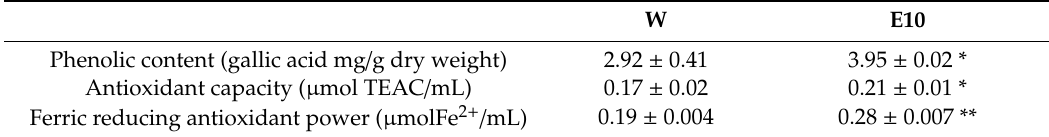
Table 2. Phenolic content and antioxidant capacity of potato water extract and potato ethanol extract. Data are reported as mean ± SE (n.3). For each row, asterisks indicate significant di ff erences between solvents (W = water, E = 10% ethanol) used for the extraction of potato peels (P) according to Student t test at p < 0.05 * or p < 0.001